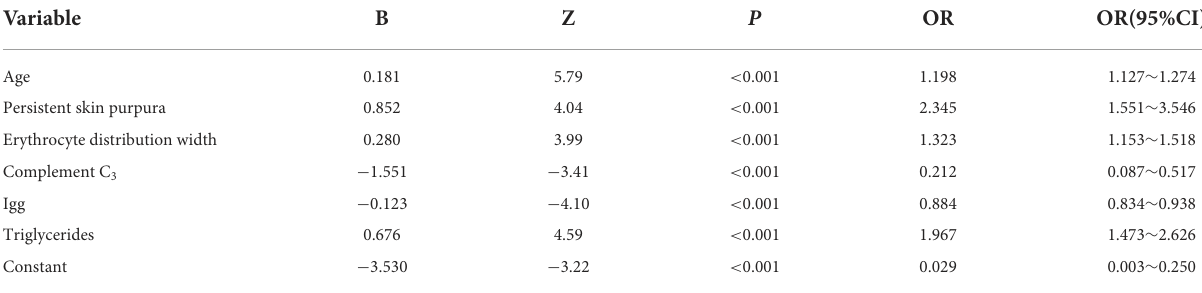
TABLE 2 Multivariate analysis of 1,007 children with